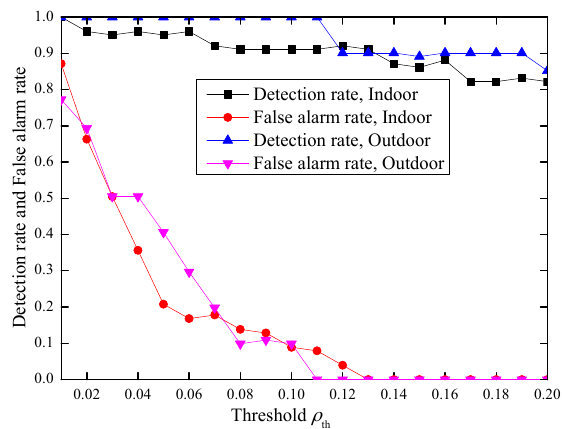
Figure 6. The average false alarm α and detection rate β with − 1 ≤ ρ ≤ 1.